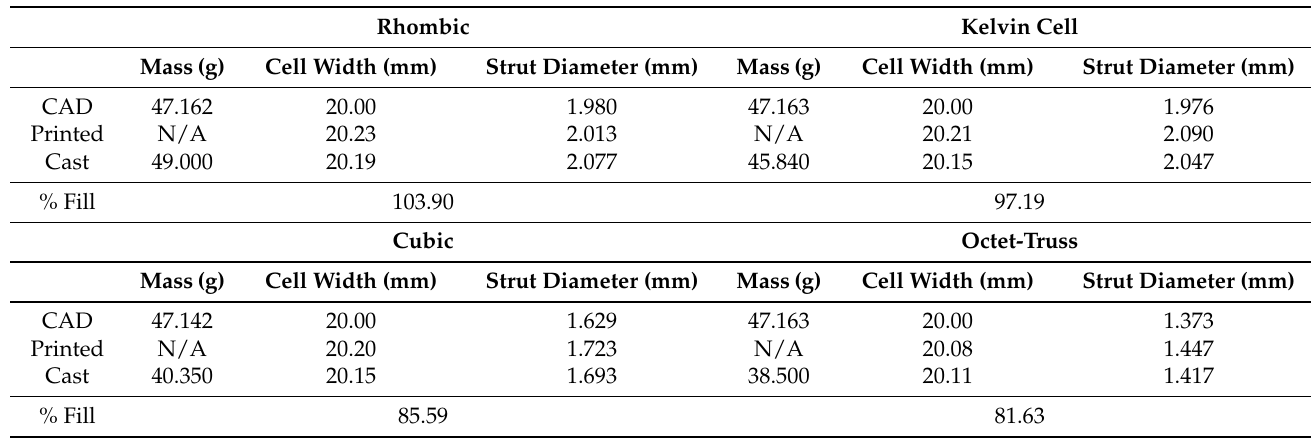
Figure 8. Set 1 cast structures: ( a ) Rhombic, ( b ) Kelvin Cell, ( c ) Cubic, and ( d ) Octet-Truss. Table 3. Lattice topology comparison casting experiment